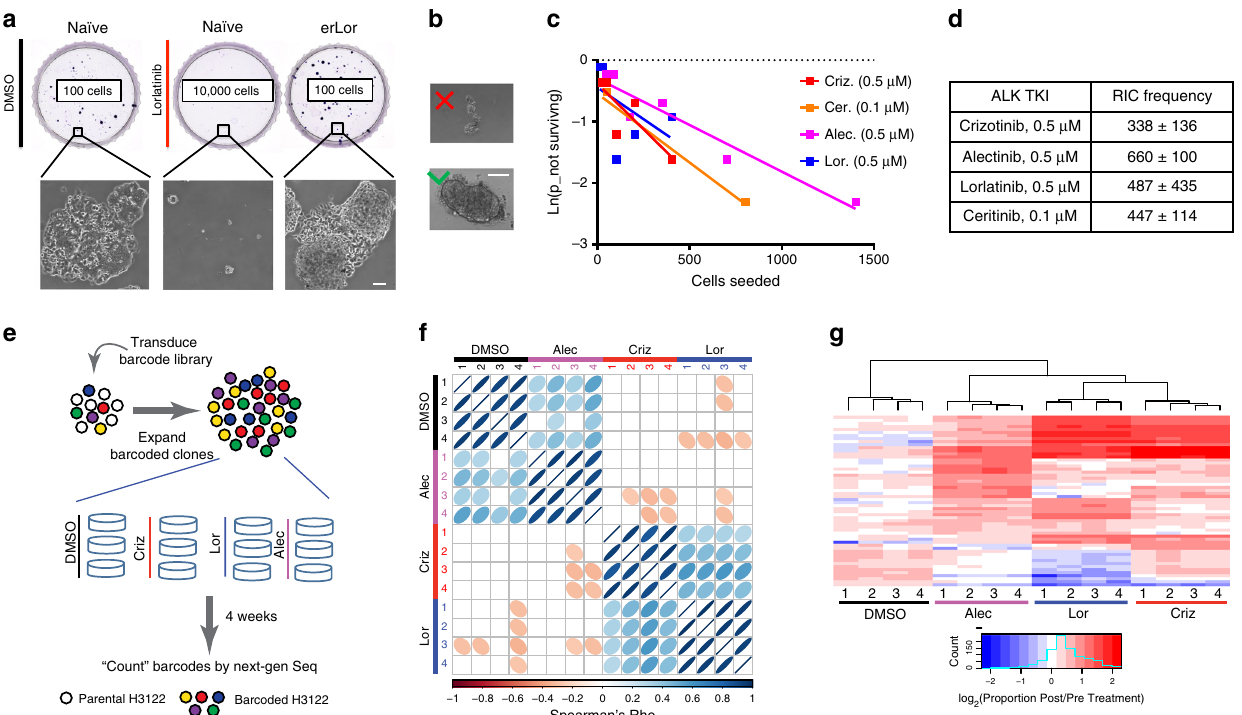
Fig. 2 Pre-existence of diverse ALK-TKI tolerant subpopulations. a Representative images of crystal violet stained whole plates and microscopic images of colonies (at ×10 magni fi cation) following 10 days of culture in DMSO or 0.5 μ M lorlatinib. b Illustration of the size cut-off criteria used for quanti fi cation of limiting dilution experiments. The scale bars in a and b represent 100 μ m. c Fitting of limiting dilution assay data and d quanti fi cation of the frequency of resistance-initiating cells. e Schemata of the clone-tracing experiment. f Spearman ’ s pairwise correlation analysis of positively selected barcodes, which have reached frequency, exceeding the highest barcode frequency in the baseline aliquot sample, between samples indicated in X and Y axes. Numbers indicate biological replicates (separate dishes). g Hierarchical clustering analysis of the positively selected barcodes shown in f . Columns indicate individual biological replicates. Rows indicate individual